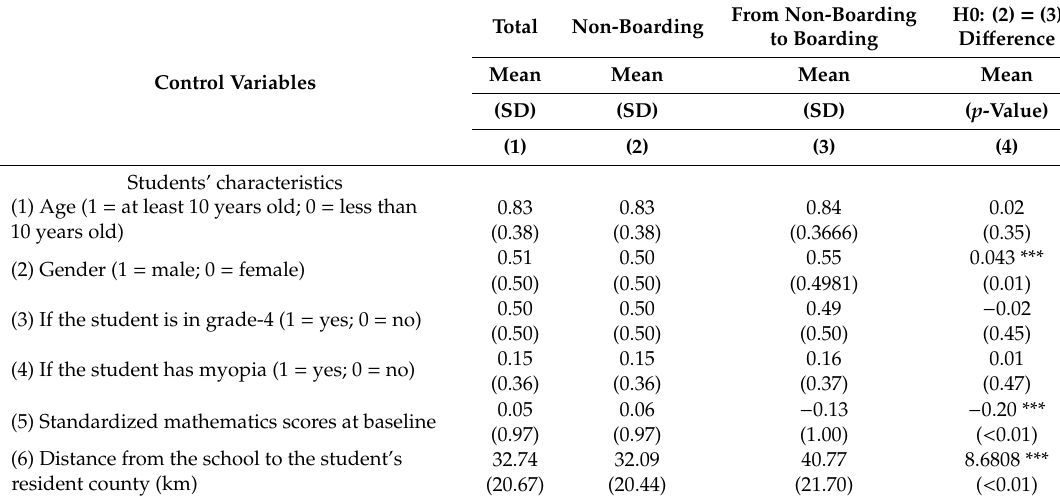
Table 3. Comparison of the characteristics of students with di ff erent boarding status at